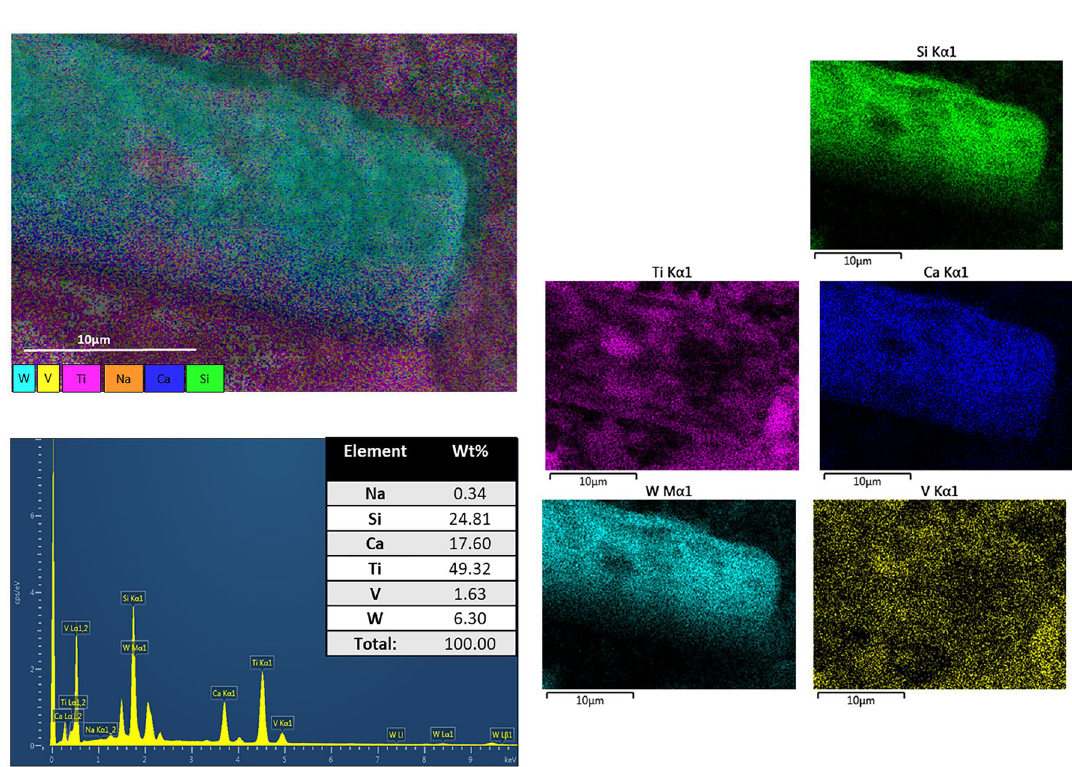
Figure 5. SEM–EDS images and element composition of raw spent SCR